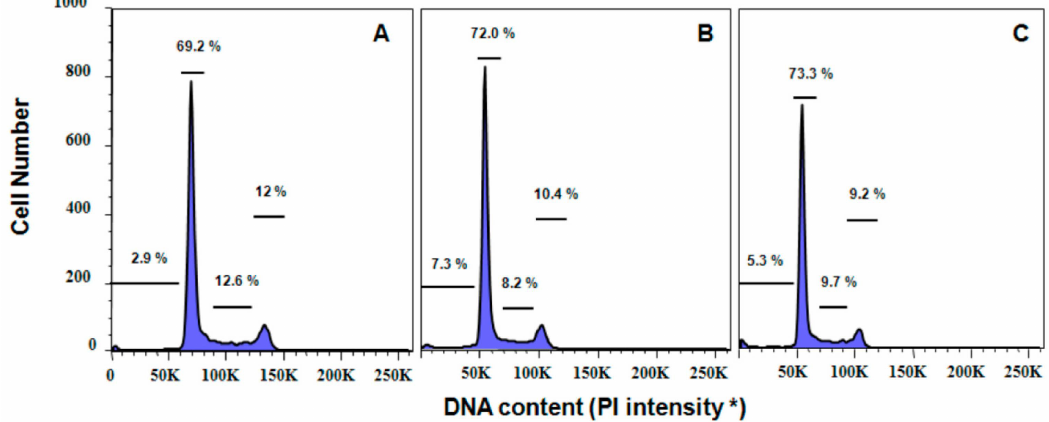
Figure 4. Cell cycle DNA histograms of HeLa cells treated with PBS (Panel A ); 4 mg/mL cultivated C. crispus extract (Panel B ); and 4 mg/mL wild-harvested P. palmata extract (Panel C ) at 24 h. Values represent (from left to right) the percentages of cells in G o , G 1 , S and G 2 M phases. * PI intensity, Propidium iodide in arbitrary units of fluorescence